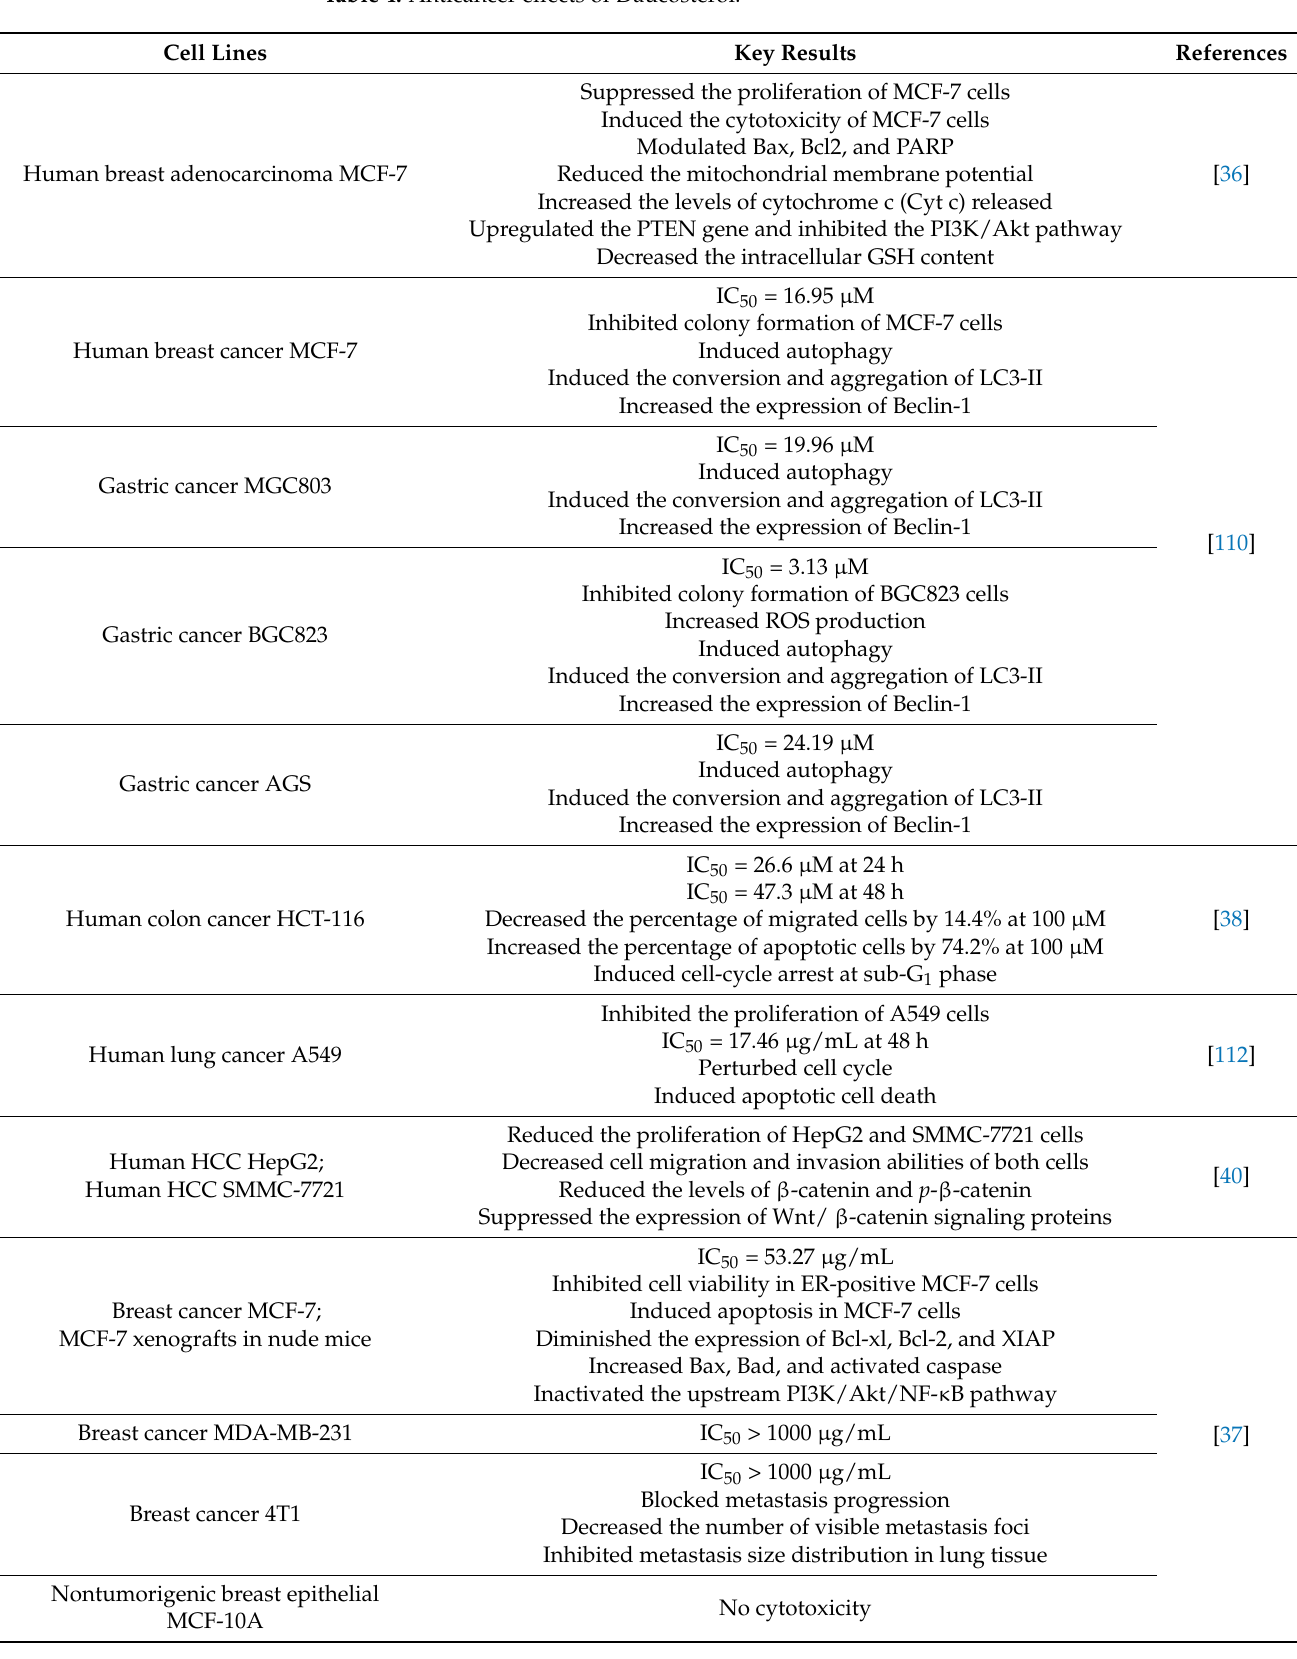
Table 4. Anticancer effects of